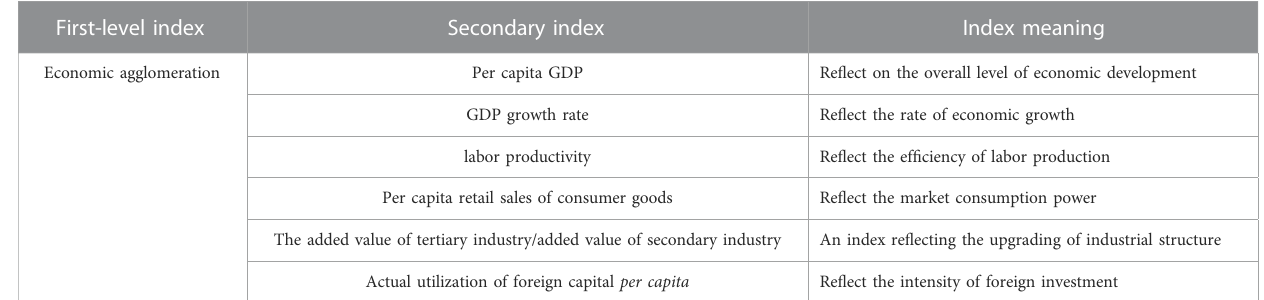
TABLE 1 Economic agglomeration index evaluation index